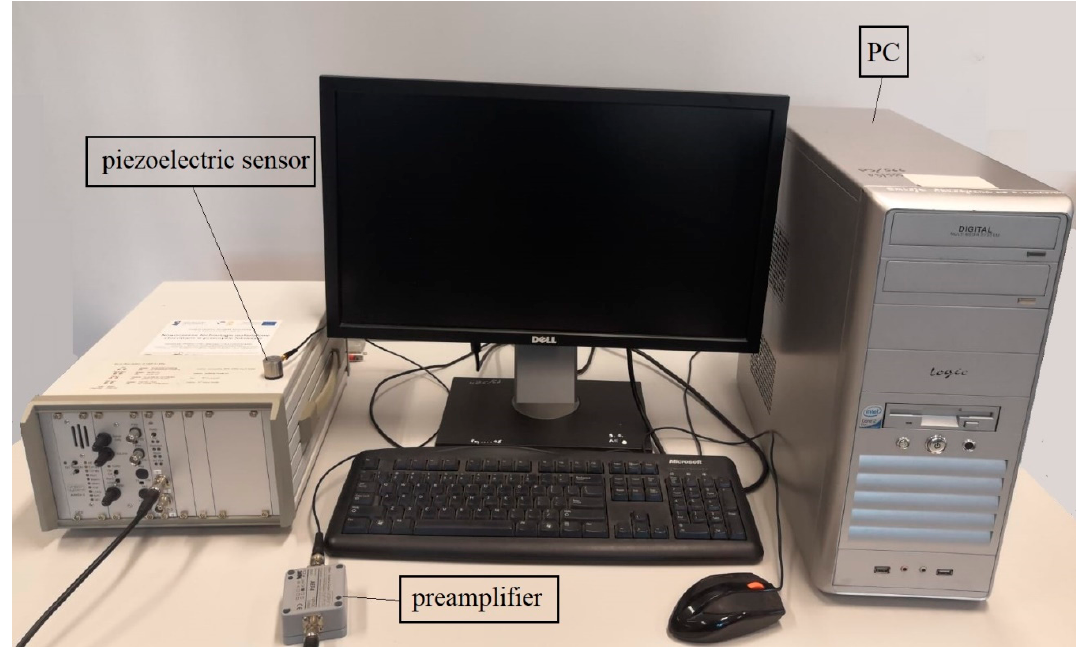
Figure 2. Acoustic emission test set up.